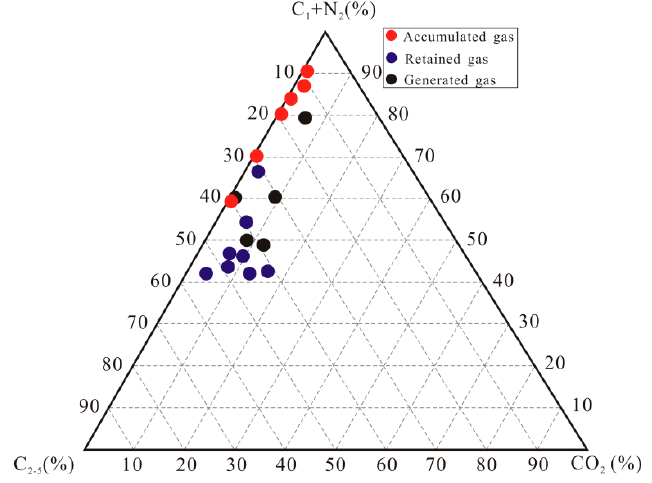
Figure 11. Ternary plots of N 2 + CH 4 , CO 2 and heavy